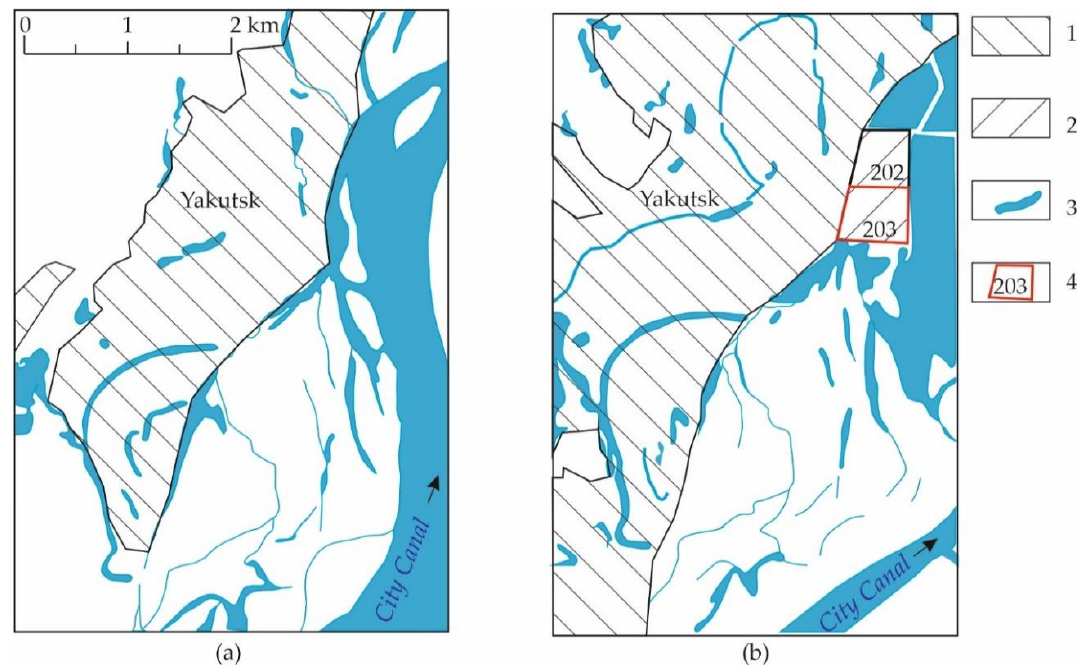
Figure 2. Layout maps of Yakutsk in 1946 ( a ) and 2019 ( b ). 1—city area; 2—reclamation area; 3—streams and lakes; 4—study area and number district.